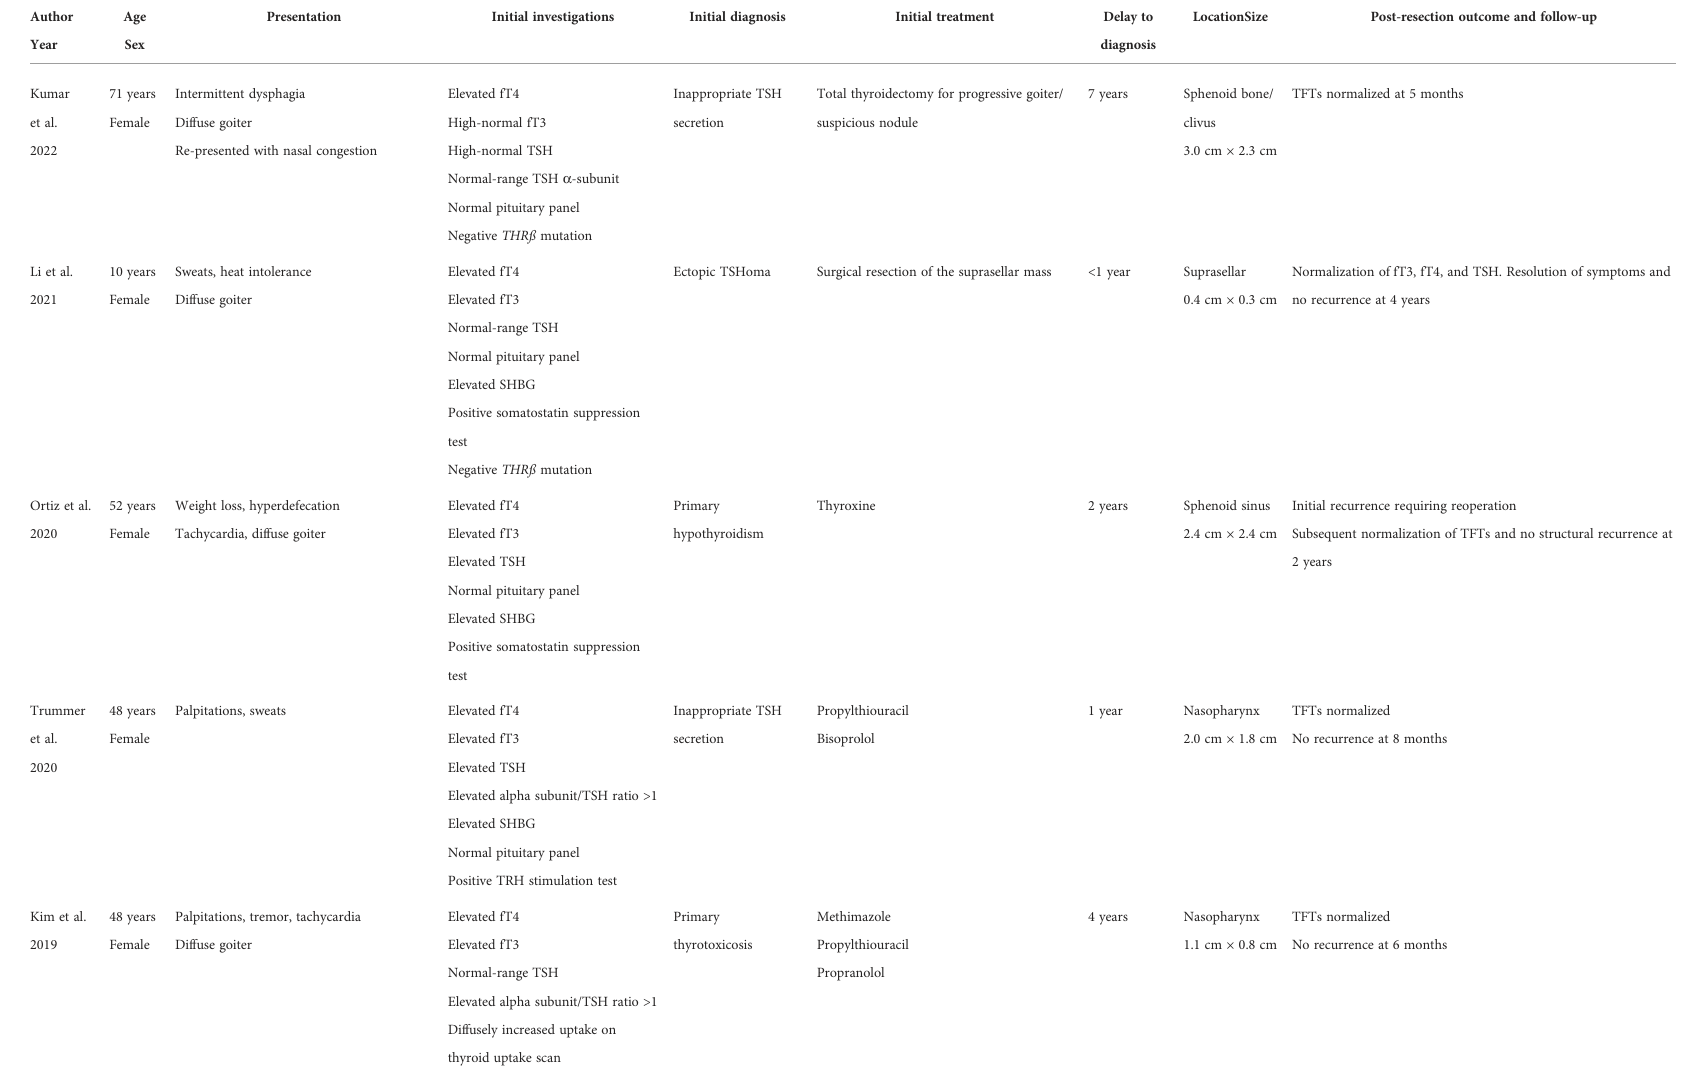
TABLE 1 Summary of the 14 published cases to-date of ectopic